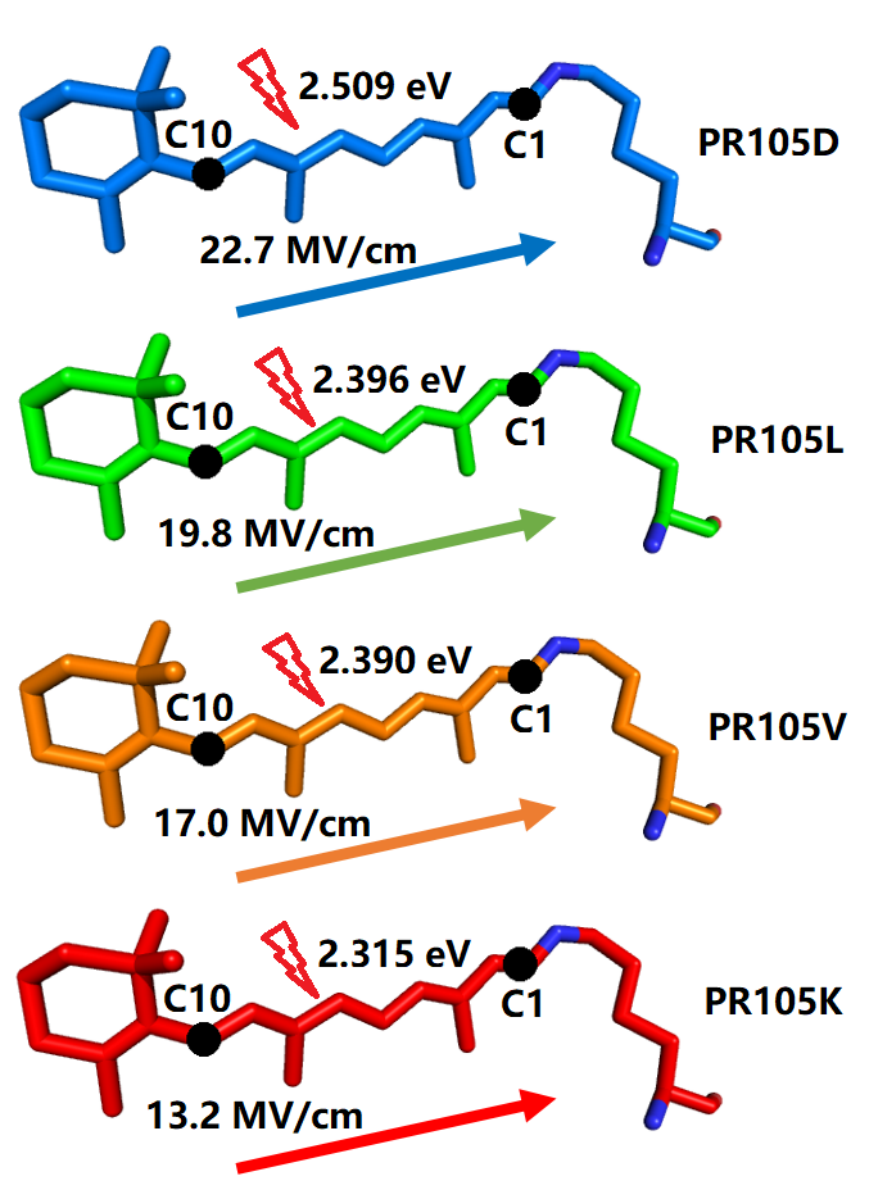
Figure 9. The calculated average electric fields and excitation energies of EE-GMFCC-1B for 100 snapshots extracted from QM/MM MD simulations of four representative mutations, namely, PR105D, PR105L, PR105V, and PR105K.